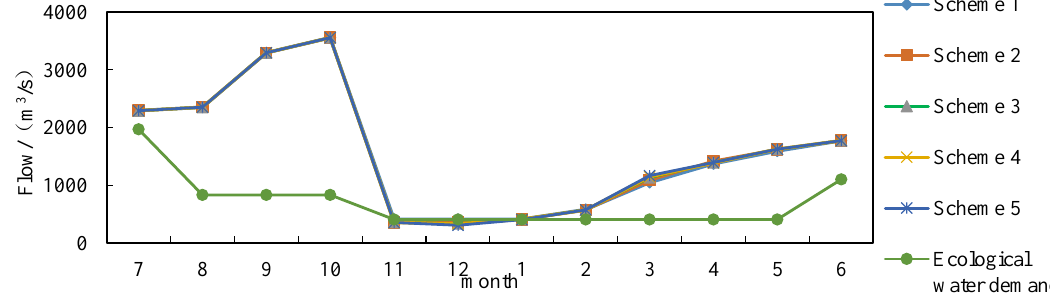
Figure 10. Comparative analysis of the outflow of Xiaolangdi in the wet year.